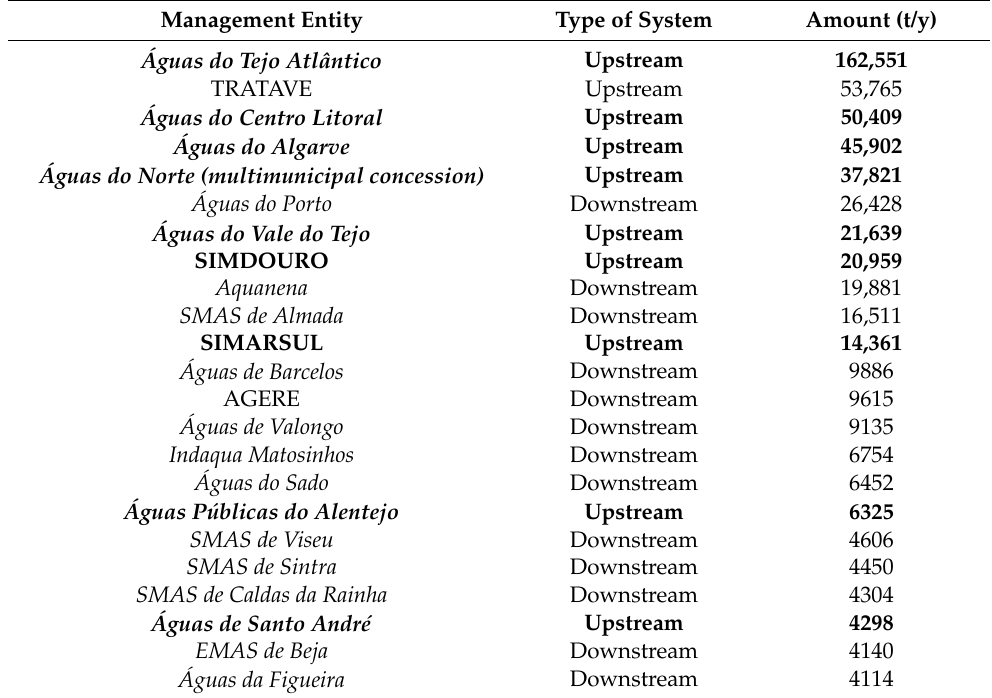
Table 1. Dewatered sludge generated by the top wastewater-sanitation-management entities (AdP group managing companies in bold)